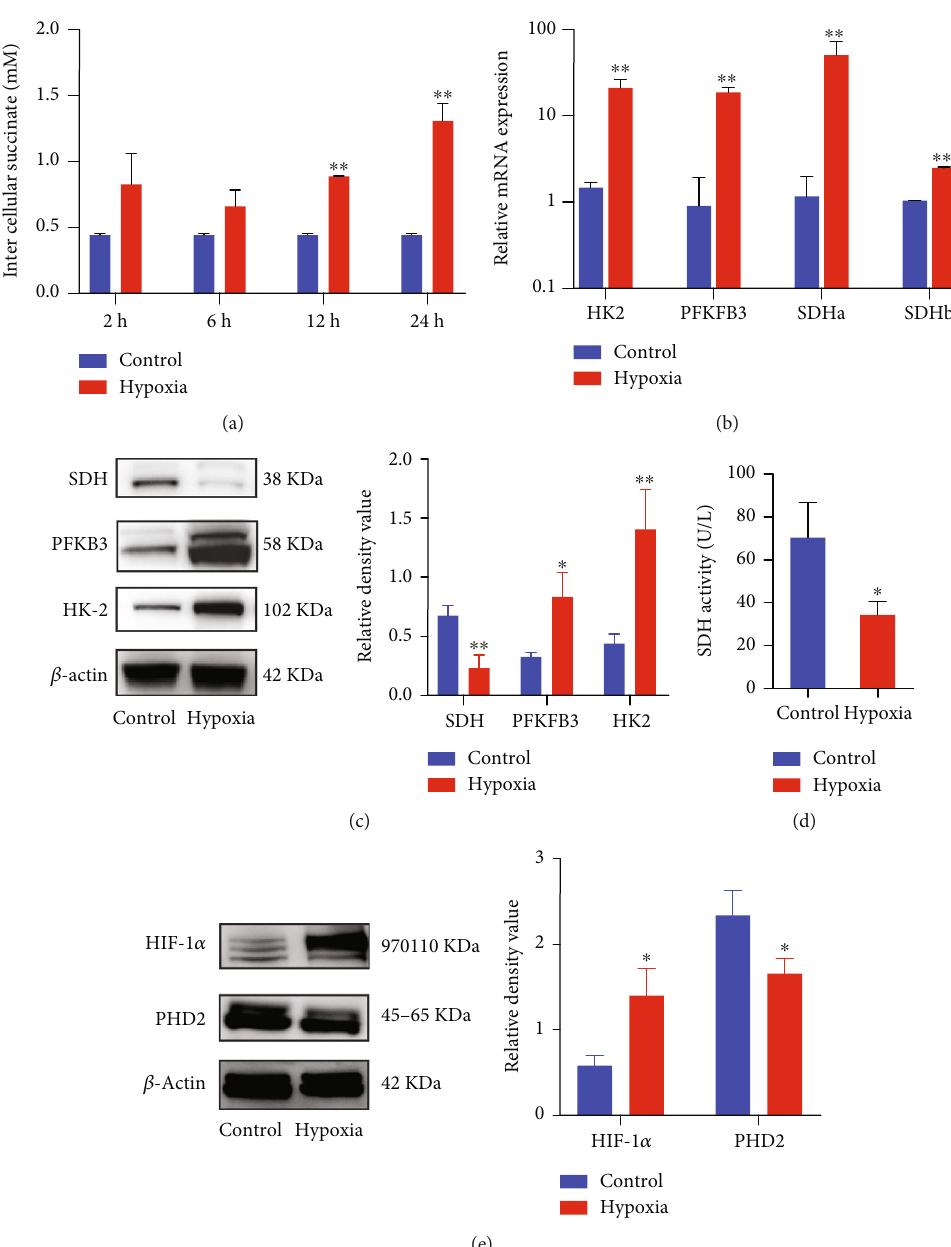
Figure 2: Hypoxia culture enhanced intracellular succinate accumulation and stabilized HIF-1 α . Levels of intracellular succinate in cell lysates were detected by the succinate colorimetric assay (a). Hexokinase 2 (HK2), 6-phosphofructo-2-kinase/fructose-2,6-biphosphatase 3 (PFKFB3), and succinate dehydrogenase (SDH) transcription at 4h were determined by qPCR ( n = 3 ) (b), while protein expression was detected by western blot at 24h (c). SDH activity at 6h was measured by ELISA (d). Protein levels of the PHD2 and HIF-1 α pathway were measured by western blot at 2 h (e). Blots were representative of 3 independent tests. ∗ p < 0 : 05 , relative to control; ∗∗ p < 0 : 01 , relative to